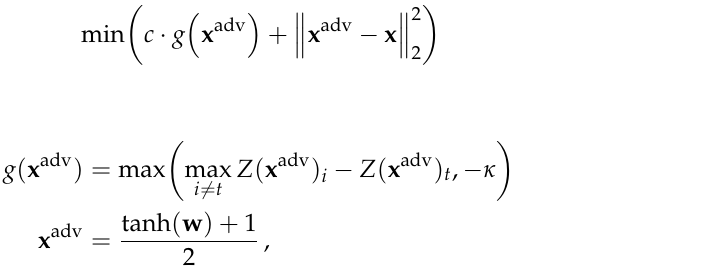
Figure 1. Convolutional layers are written in the format kernel width padding is always set to 1. For MNIST, K = 64, and for CIFAR-10, K =